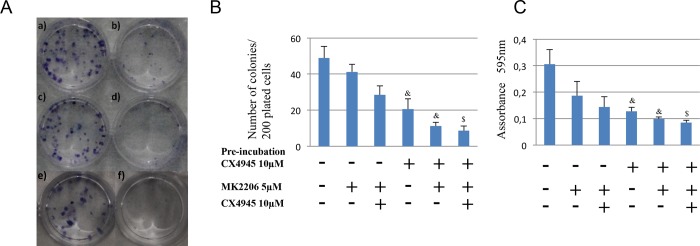
Clonogenic assays.The number of colonies (A and B) and the absorbance of the extracted dye (crystal violet) measured at 595 nm (C) indicate the clonogenic potential of CCA cell cultures. We tested the clonogenic capacity of mucin-IHCCA cells after sequential treatment with CX4945 (72 hrs) and MK2206 (48 hrs) versus their combination. The sequential treatment of CX4945 followed by MK2206 showed the highest inhibitory effect on mucin-IHCCA cell growth. We calculated the numbers of colonies and the absorbance of the extracted dye at 595 nm. & = p<0.05 vs non pre-incubated conditions. $ = p< 0.05 vs others columns. Mean +/- SD of N = 3–5 independent experiments.